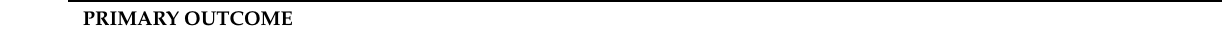
Table 2. Outcome